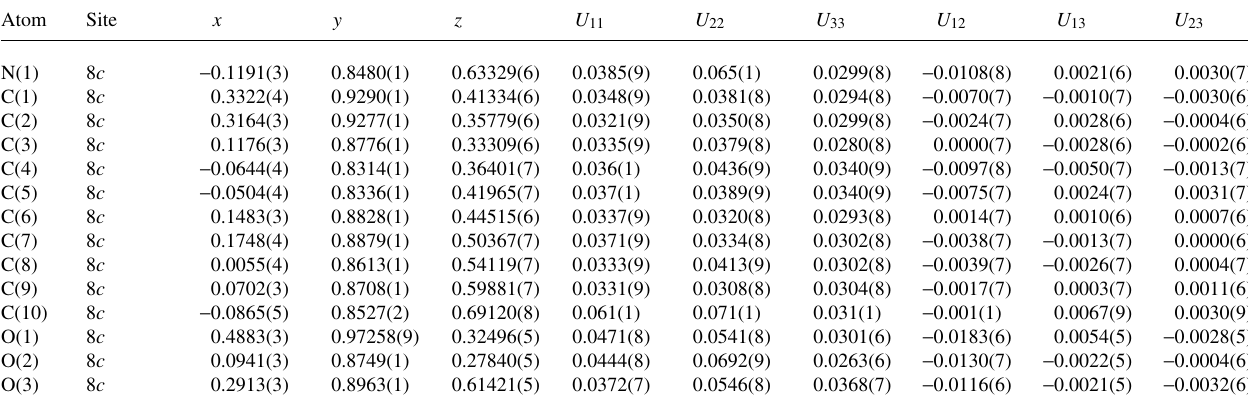
Table 3. Atomic coordinates and displacement parameters (in Å 2 )